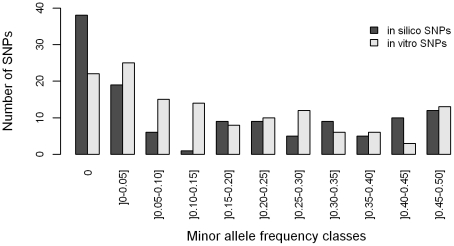
Allele frequency spectrum for 257 successfully genotyped in vitro and in silico SNPs.